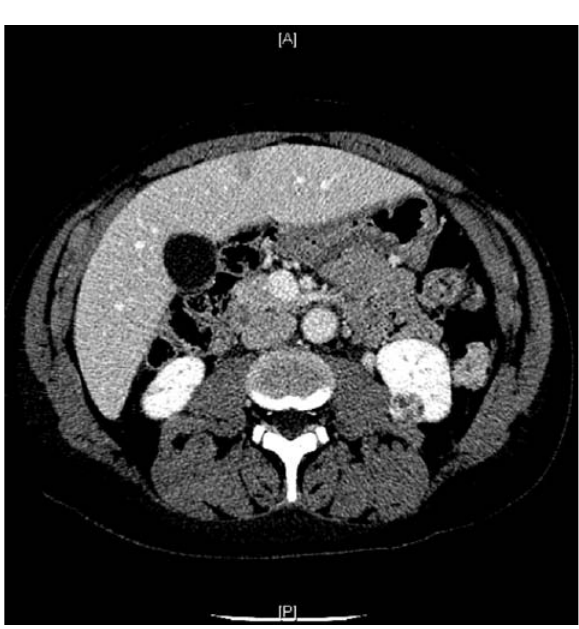
Figure 1 – CT scan showing enhancing 2.5 cm lower pole mass.